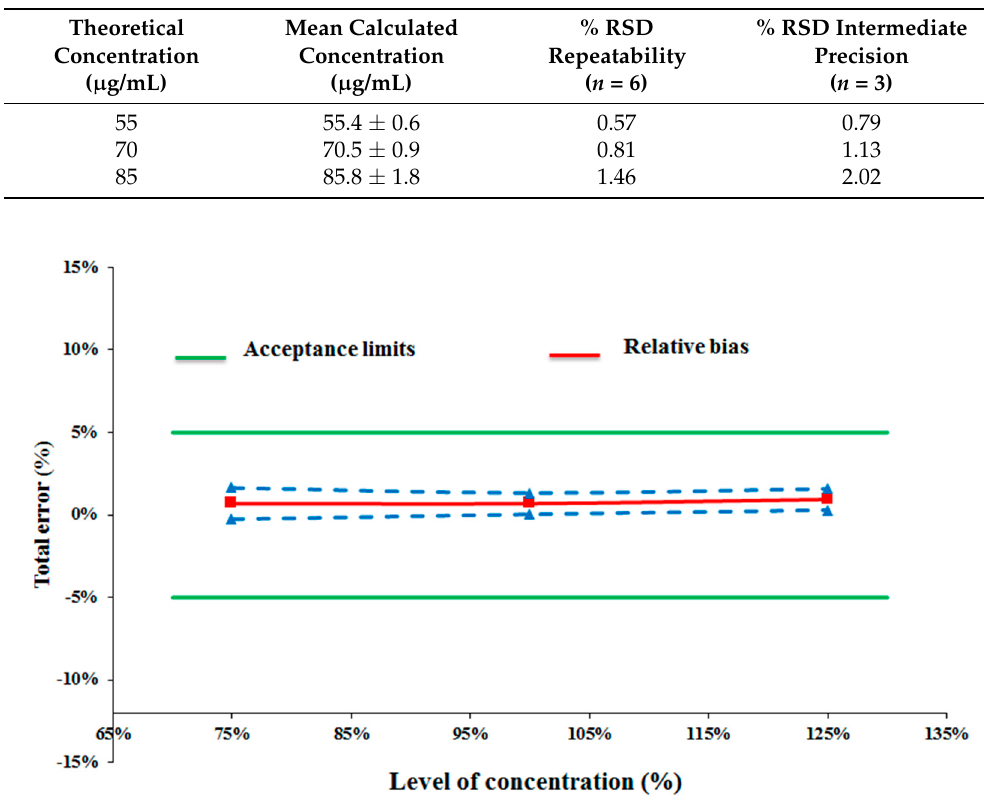
Table 2. Relative standard deviation values (%) for repeatability and intermediate precision (IQC). Definition: relative standard deviation (RSD).